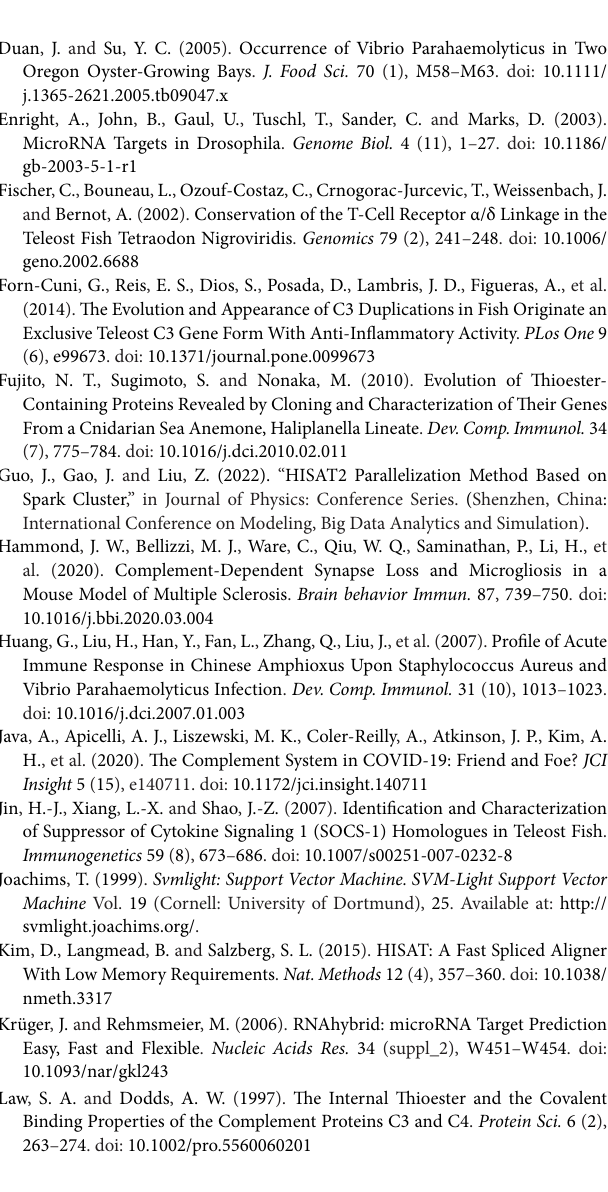
Supplementary Figure 1 | A pipeline overview of the integrated transcriptome, miRNA, and proteome analysis on the molecular mechanisms for T. nigroviridis in resistance to exogenous V. parahaemolyticus infection. The molecular and functional evolution of the essential genes C3 and C1qA were examined. Supplementary Figure 2 | miRNA analysis of DEMs. (A) Statistics of differential expressed miRNAs. (B) Negative correlations of miRNA-target gene pairs. Supplementary Figure 3 | GO enrichment of differentially expressed proteins (DEPs) from the DIA analysis. Supplementary Figure 4 | A phylogenetic tree of C3 in various animals. Supplementary Figure 5 | Synteny analyses of C1qA genes in various vertebrates. Black arrows mark these C1qA genes. Supplementary Figure 6 | Sequence alignment of C1qA proteins from various vertebrates. The solid red boxes mark the C1qA structure. CLR, Collagen like region; C1q domain, Globular C1q domain; SP, signal